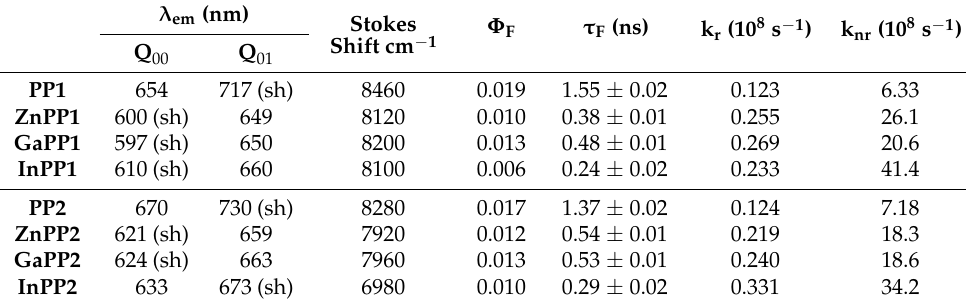
Table 2. Photophysical parameters of PP1 , PP2 and their metal complexes in toluene. Q yo1 , Qy 00 , Q xo1 , Q x00 ) is shown in Figure 2. The equations for the determination of fluorescence quantum yield ( Φ F ) and lifetime ( τ F), the radiative (k r ) and non-radiative (k nr ) rate constant are provided in Section